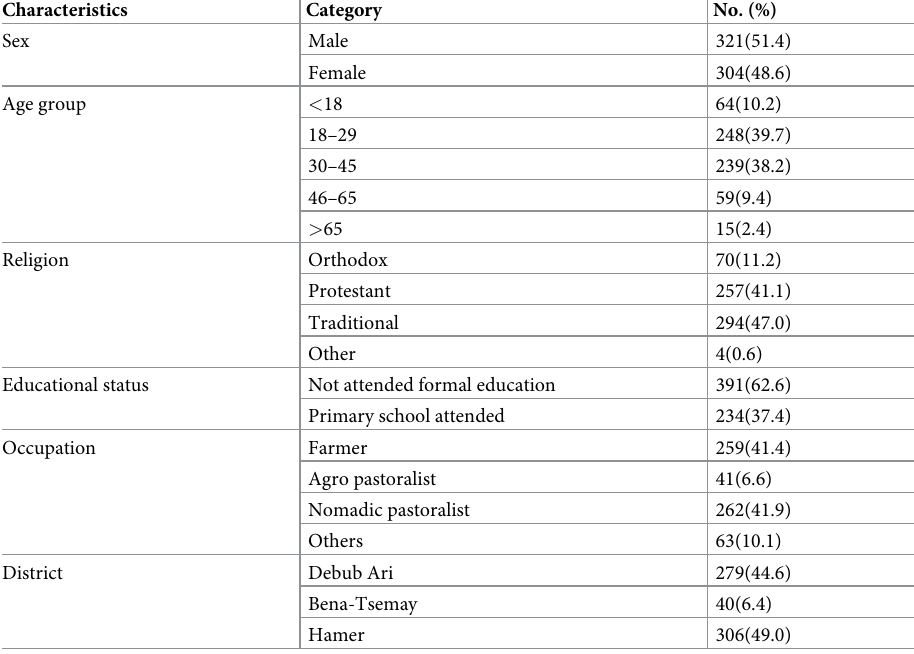
Table 1. Socio-demographic characteristics of the study